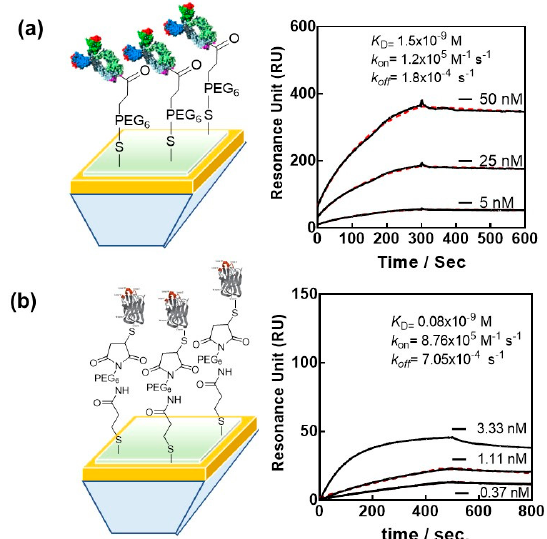
Figure 4. Affinity of different engineered SARS-CoV-2 antibodies: ( a ) Oriented linkage of nanobody VHH-72-Fc together with sensogram (Reprinted with permission from Ref. [25], 2022, RSC). ( b ) Binding affinities of nanoCLAMP P2712L (6His-P2710-linker-P2609-linker-Cys) to Wuhan-RBD. Gold chips were modified with a maleimide linker. Running buffer: 20 mM MOPS, 150 mM NaCl, 1 mM CaCl 2 and 1% BSA as blocking agent (pH 6.5). Black lines depict binding data, and red lines display the 1:1 binding model fit.